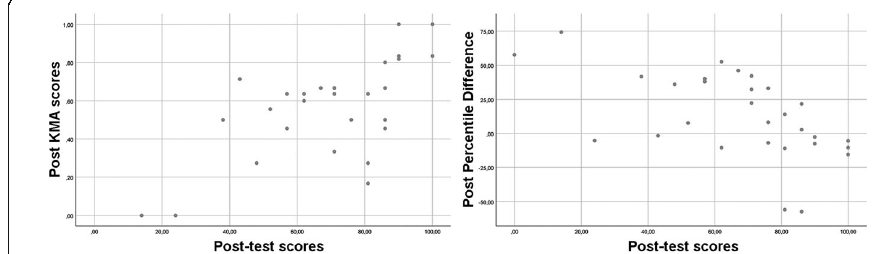
Fig. 6 Scatter plots showing the relationships between academic achievement measured by the post-test and absolute and relative knowledge monitoring abilities. Note that better abilities mean higher KMA ssscores (left) but lower percentile differences